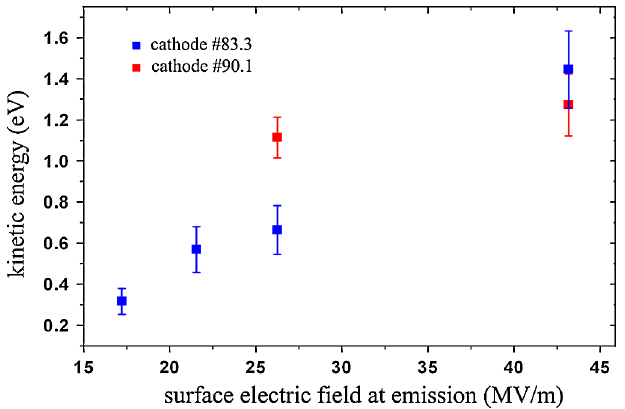
FIG. 17. (Color) Kinetic energies of emitted electrons for two Te cathodes as a function of the electric field during emis- Cs 2 sion. The error bars represent only the statistical uncertainties of the analysis